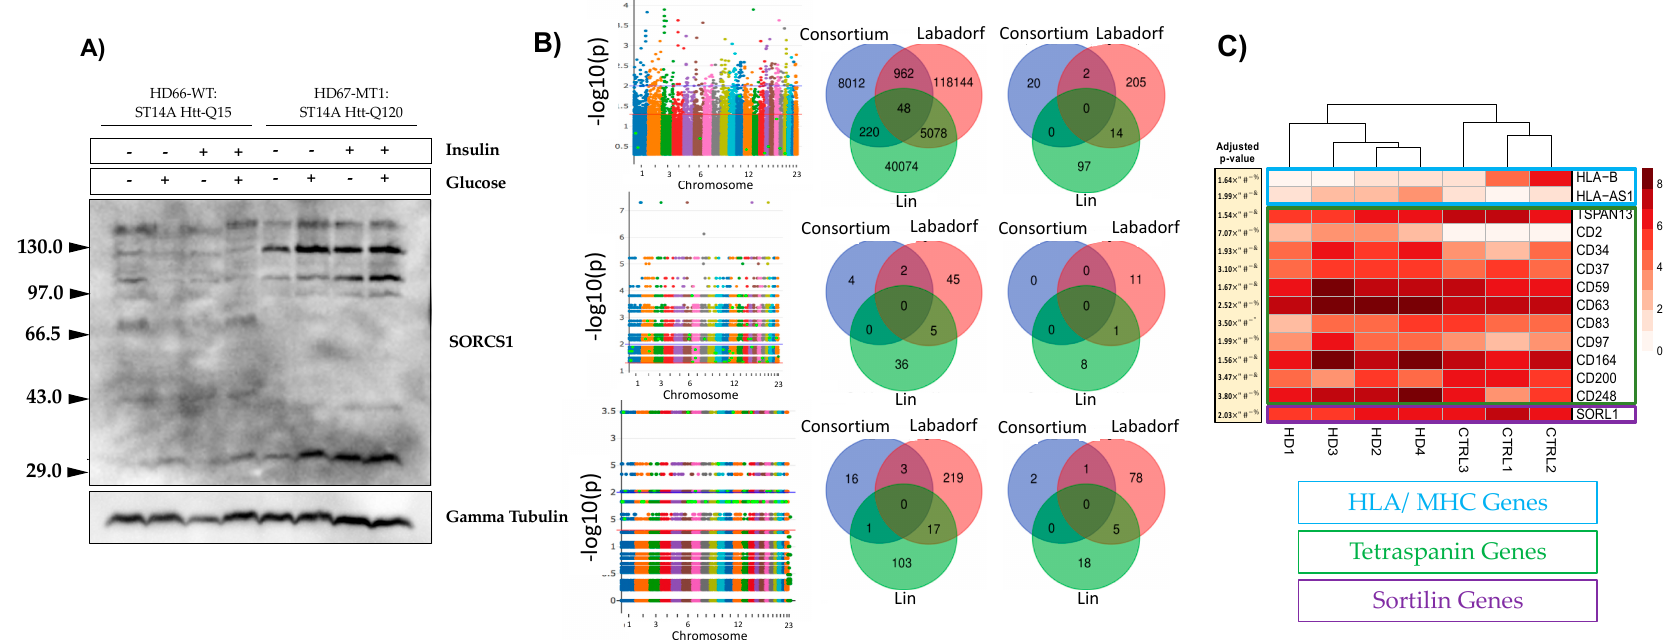
Figure 2. Influence of the mutant huntingtin (mHTT) on the expression and genetic variance of sortilin genes in Rattus norvegicus (A) and human (B). ( A ) Western blot of sortilin related VPS10 domain containing receptor 1 (SORCS1) protein in ST14A cells after overnight exposure to a growth medium containing glucose and bovine insulin; ( B ) Manhattan plots showing SNPs detected in Labdorf, Lin and HD iPSC Consortium datasets (top to bottom) (iPSC: induced Pluripotent Stem Cells). Venn diagrams depict SNPs detected in three human datasets analyzed per sortilin gene (HD iPSC Consortium, Blue; Labadorf 2015, Red; Lin 2016, Green). First the Venn diagram in the top shows SNPs in the three human datasets associated with HD ( p < 0.05). The other five Venn diagrams show SNPs flanking the five sortilins (SORT1, SORL1, SORCS1, SORCS2 and SORCS3, from top to bottom); ( C ) RNA-Seq analysis using the DESeq2 R package on the HD iPSC Consortium dataset. Blue: MHC/HLA; Green: Tetraspanins; Purple: VPS10P (sortilins).